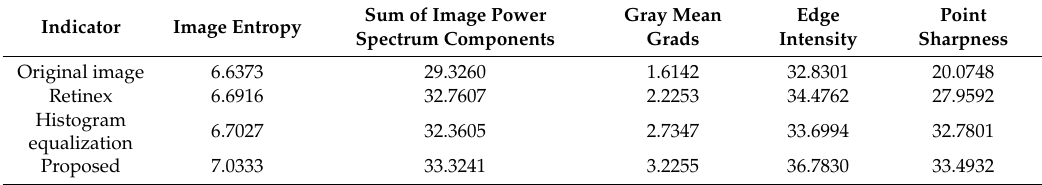
Table 1. Quantitative evaluation of image quality with di ff erent sharpening